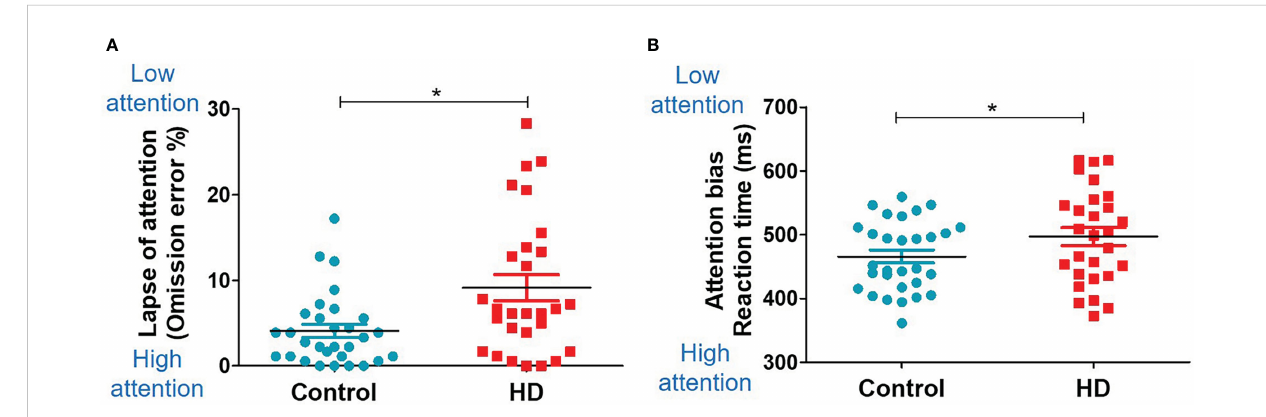
FIGURE 4 Food-related cognition (Go/NoGo task). Scatter plots for the Go/NoGo task results in the HD and control groups. The unpaired, two-sample Student ’ s t -test was used for comparing the HD and control groups. (A) Group difference in the omission error rate (missing response to the Go trial). (B) Group difference in the reaction time. * indicates signi fi cance